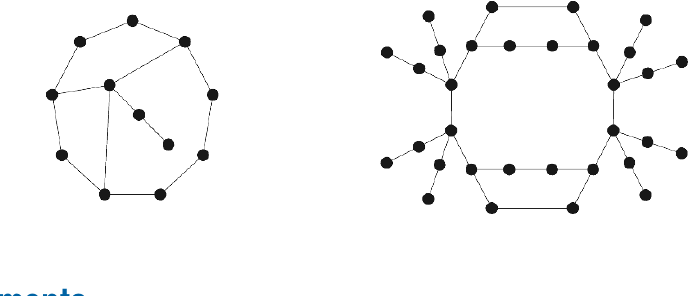
Figure 5. Tricyclic graphs with exactly two main eigenvalues and δ